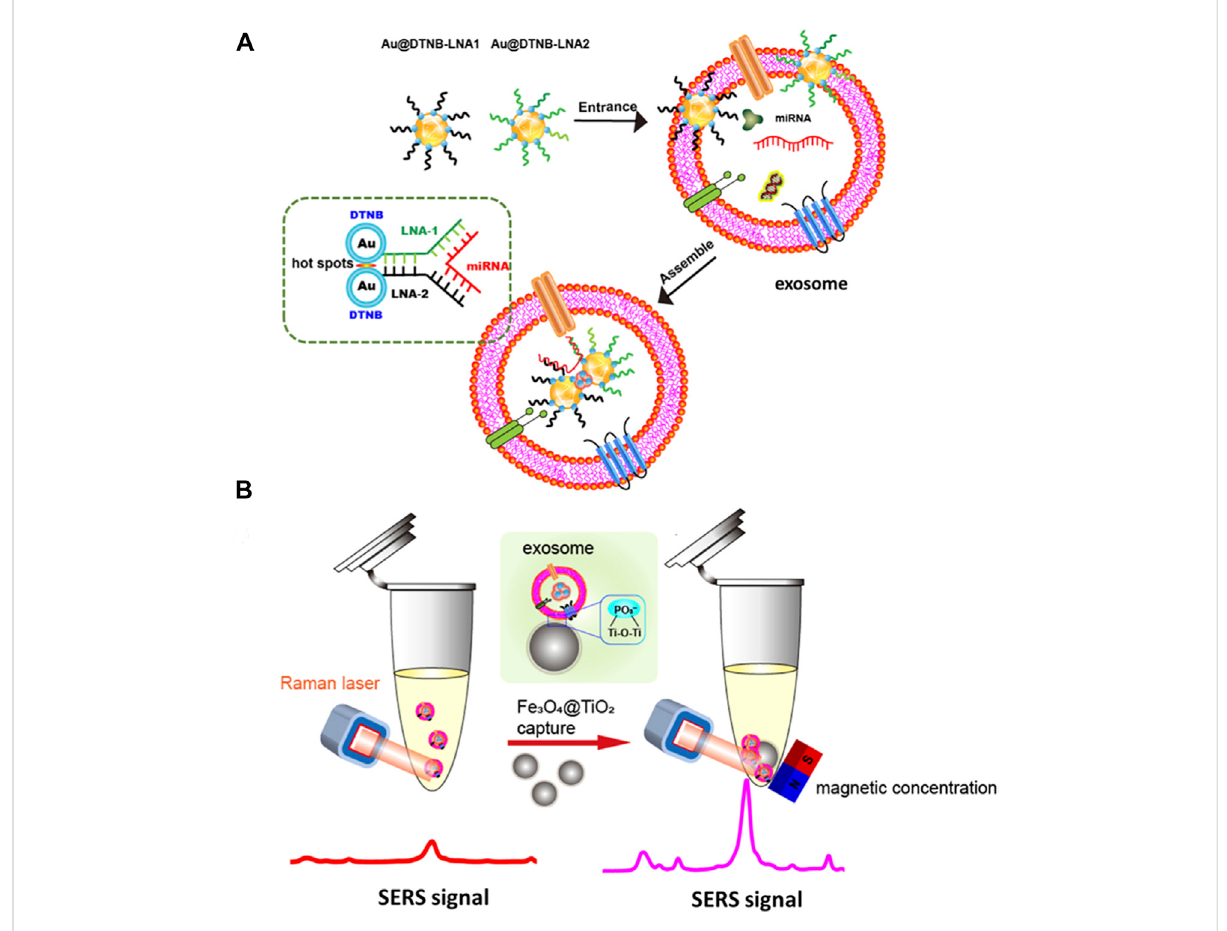
FIGURE 8 Exosomal miRNA in situ detection using SERS biosensor combined with Fe 3 O 4 @TiO 2 -based concentration. SERS tags are adsorbed to exosomes and bind to the target exosomal miRNA (A) . The hot spots and SERS intensity increase, and SERS intensity increases as Fe 3 O 4 @TiO 2 captures exosome for in situ detection of exosomal miRNAs (B) . Reprinted with permission from Jiang et al.